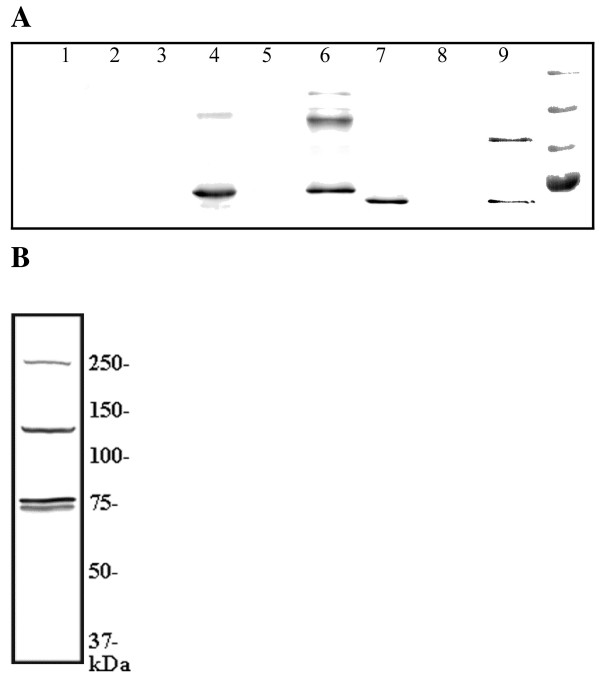
Detection of ACSL6 isoforms in E. coli (A) and in human K562 cells (B). A: vector (1, 2, 3); ACSL6_v2 (4, 5, 6); ACSL6_v3 (7, 8, 9). Crude extract (1, 4, 7); Soluble fraction (2, 5, 8); Membrane fraction (3, 6, 9). Detection performed with Pierce INDIA HIS-antibody. Protein ladder standard is shown on the right (top to bottom: 250-150-100-75 kDa). Proteins carried a hexahistidine-tag at their amino-terminus (see Methods). B: Total protein extract of K562 cells. Detection performed with a peptide raised antibody against ACSL6.